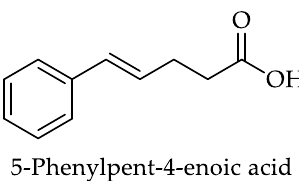
Figure 19. Structure of 5-phenylpent-4-enoic acid, a hydroxyphenylpentanoic acid (HPPeA) ( 142 , Table 13). Table 13. hydroxyphenylpentanoic acid (HPPeA) reported in monofloral honeys.